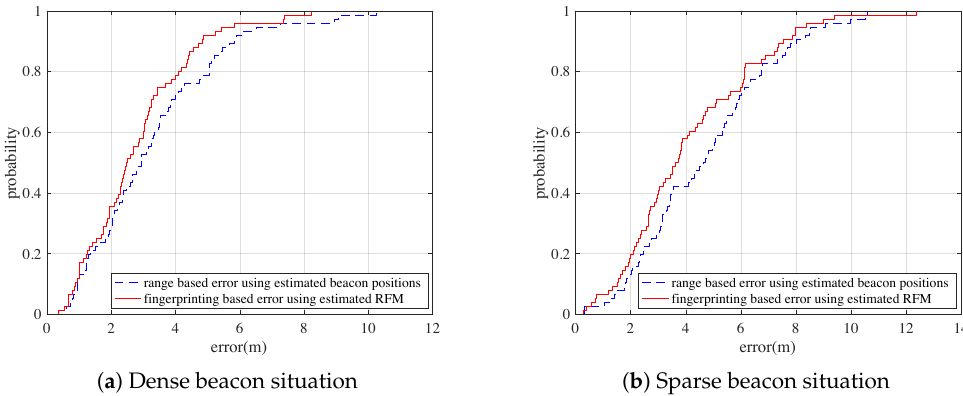
Figure 12. CDF comparison for range-based errors and fingerprinting-based errors under dense and sparse beacon situations using estimated beacon positions and